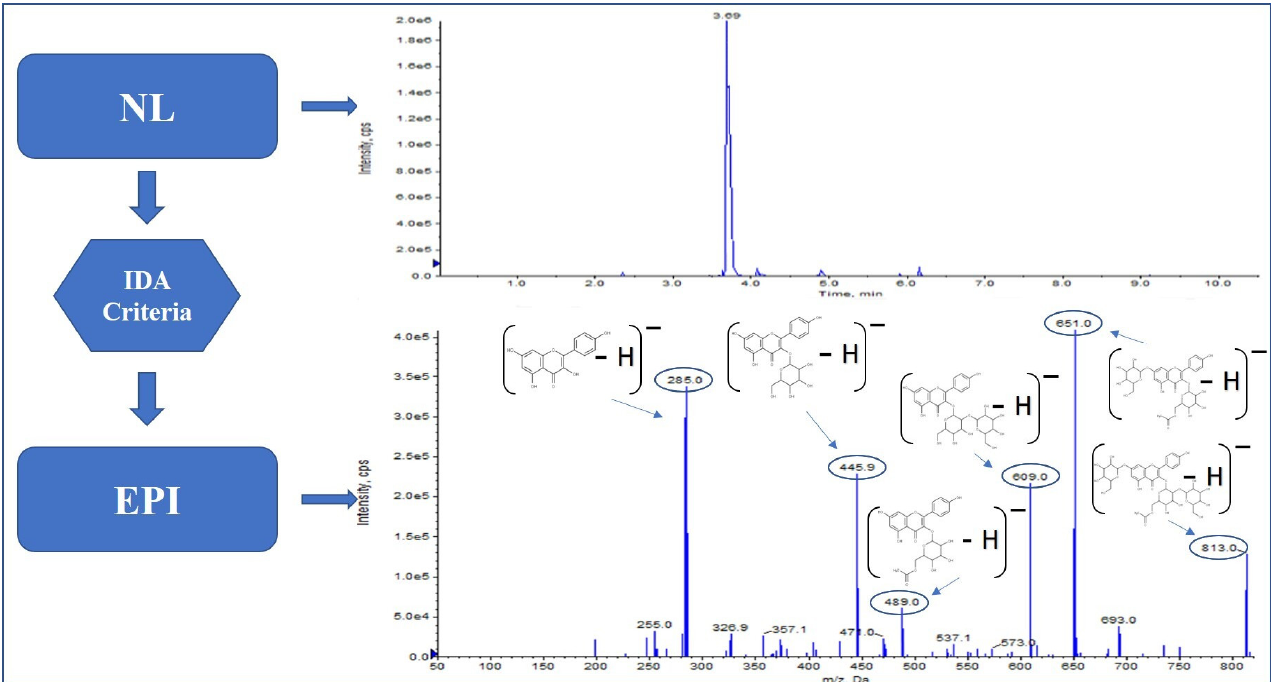
Figure 3. Kaempferol-glucosyl-(1->2)-(6’’-acetylgalactoside)-hexoside fragmentation pattern in Saffron.